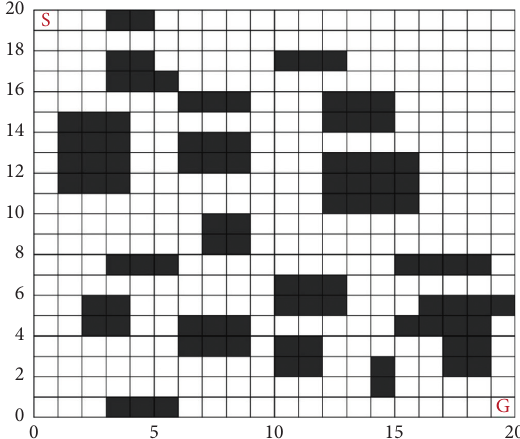
Figure 1: Environment model of grid